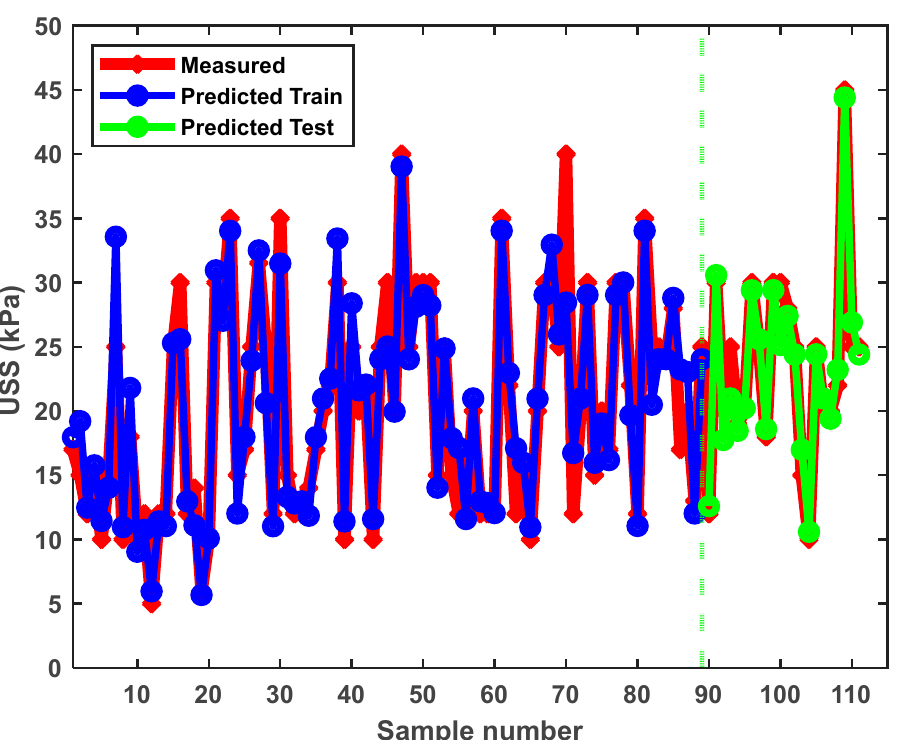
Figure 6. Comparison results of the trained model, predicted versus actual output data of vane- tested USS. The straight line denotes to line of equality .